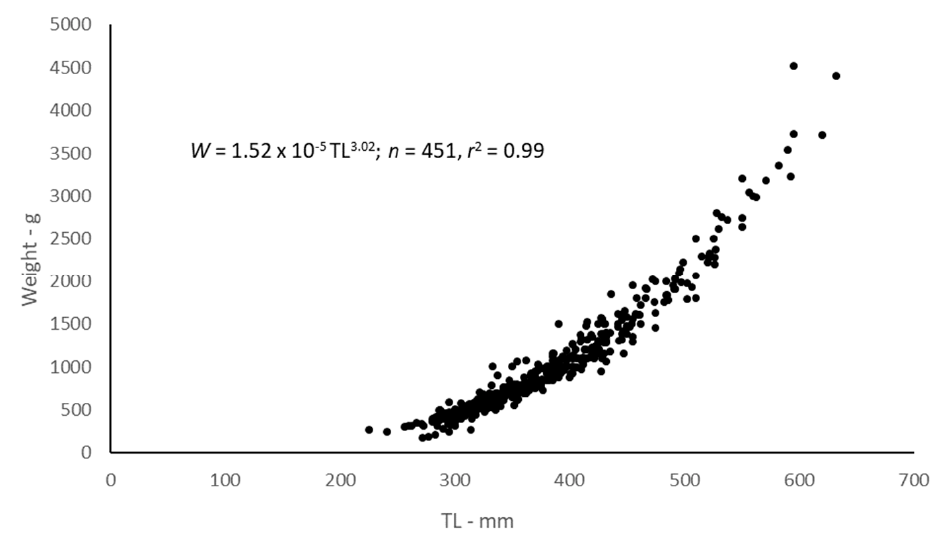
Figure 7. Weight–total-length relationship for black margate, Anisotremus surimanensis , for all fish measured by the Southeast Region Headboat Survey from 1972 to 2018.